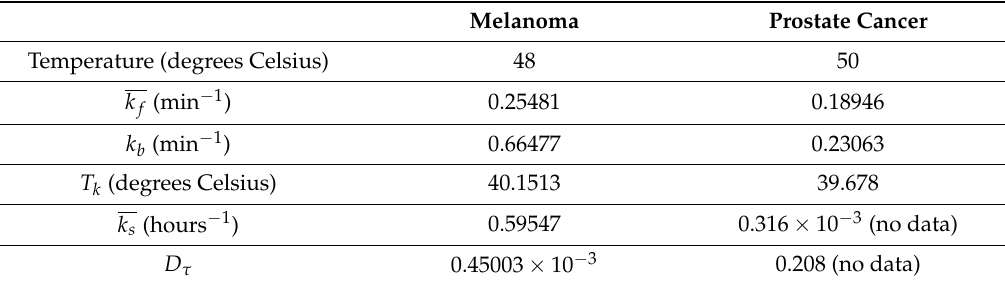
Table 4. Parameters for the hyperthermic cell death model.